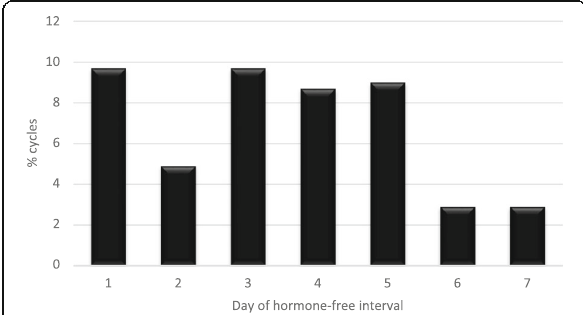
Fig. 3 First migraine episode at each day of the hormone-free interval of combined hormonal contraceptive